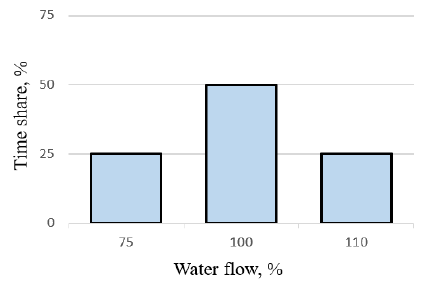
Figure 4. Pump loading diagram.